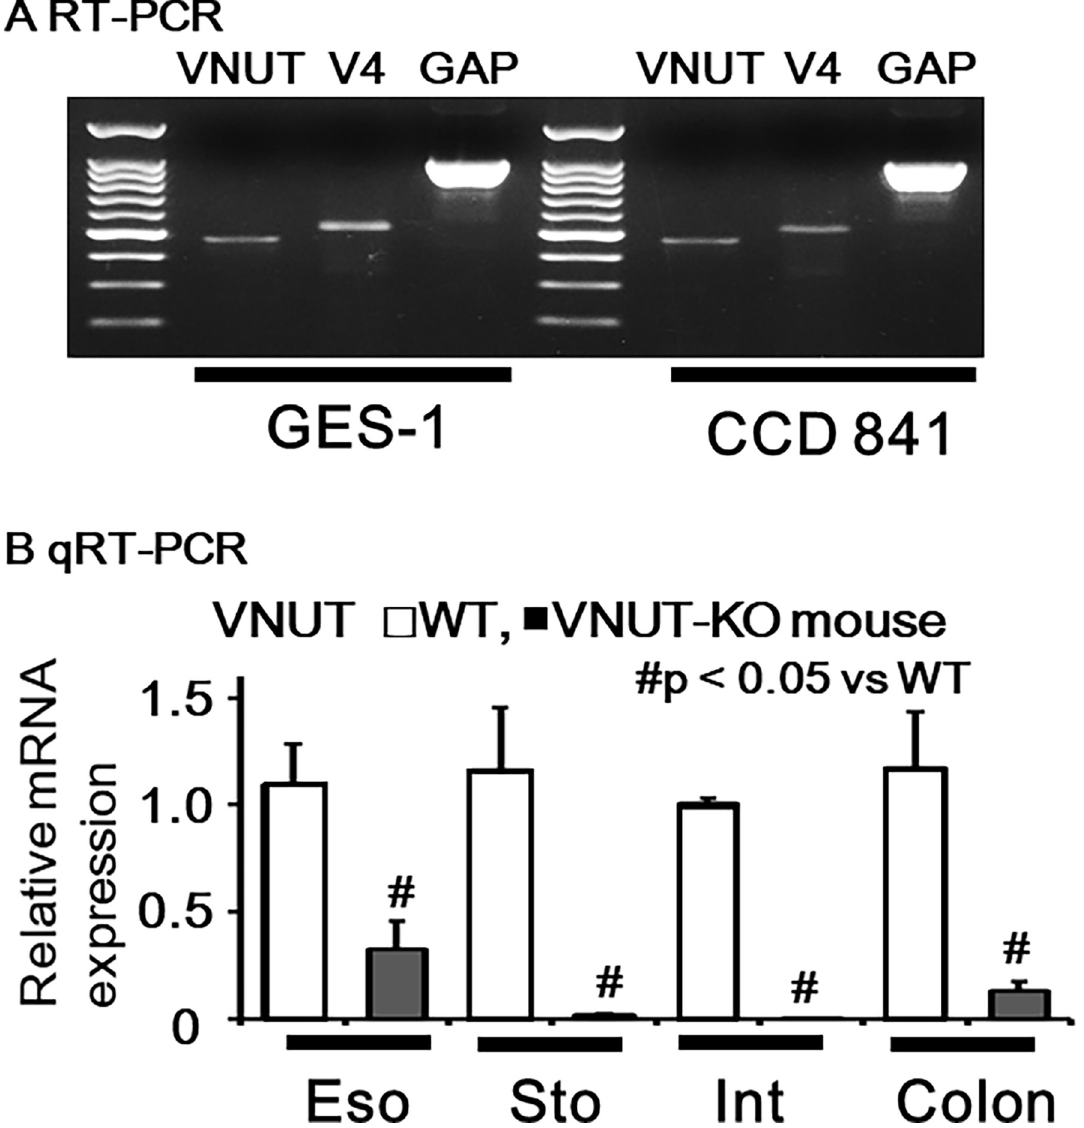
Fig 1. VNUT and/or TRPV4 mRNA expression in human cell lines and mouse tissues. (A) VNUT, TRPV4 (V4) and GAPDH (GAP) mRNA was detected in human gastric (GES-1) and colonic (CCD 841) epithelial cell lines. (B) Quantitative RT- PCR (qRT- PCR) indicated significantly lower mRNA expression in VNUT-knockout (KO) tissues (Eso; esophagus, Sto; stomach, Int; intestine, Colo; colon) compared to wild-type (WT) tissues (# P < 0.05 vs WT). (Fig 2A). Strong homogenous immunofluorescent signal was confined to the epithelial cell layer in WT mouse tissues but not in VNUT-KO tissues (Fig 2B), demonstrating the ubiqui- tous expression of VNUT in the gastrointestinal epithelium and the specificity for VNUT.